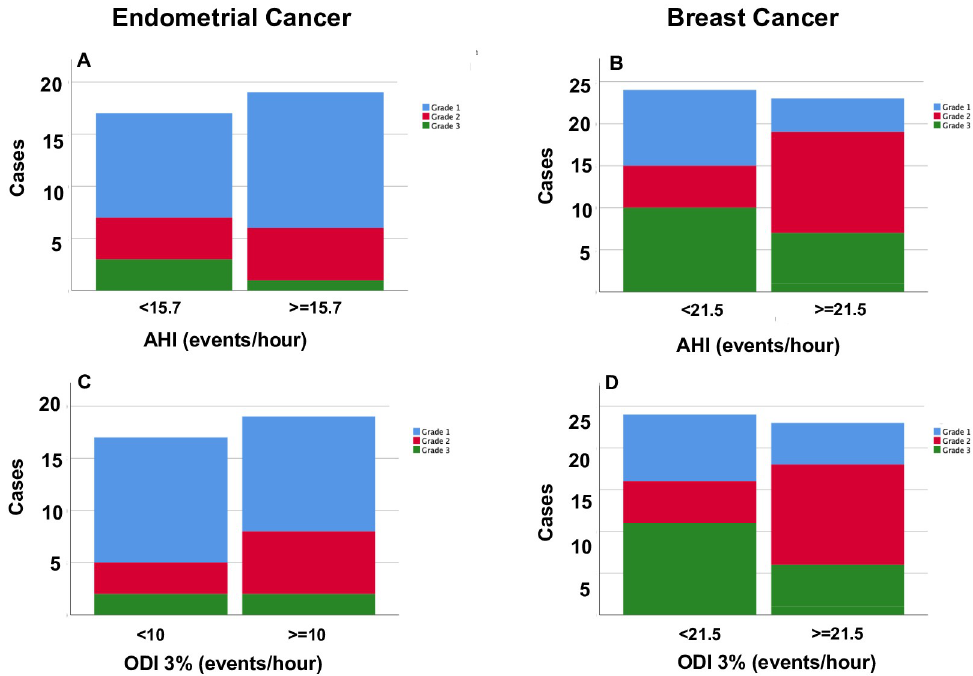
Fig 2. Frequency distributions for histopathological grades for endometrial cancer (Grade 1–3 (11]) (A, C) and breast cancer (Nottingham Grade 1–3) [10] (B, D), plotted against the OSA categorical variables determined from median values for apnea hypopnea index (AHI events/hour) and oxygen desaturation index (ODI 3% events/hour) for each of the cancer patients. There were no significant differences in the distribution of histological grades (all p > 0.1, Fisher’s exact